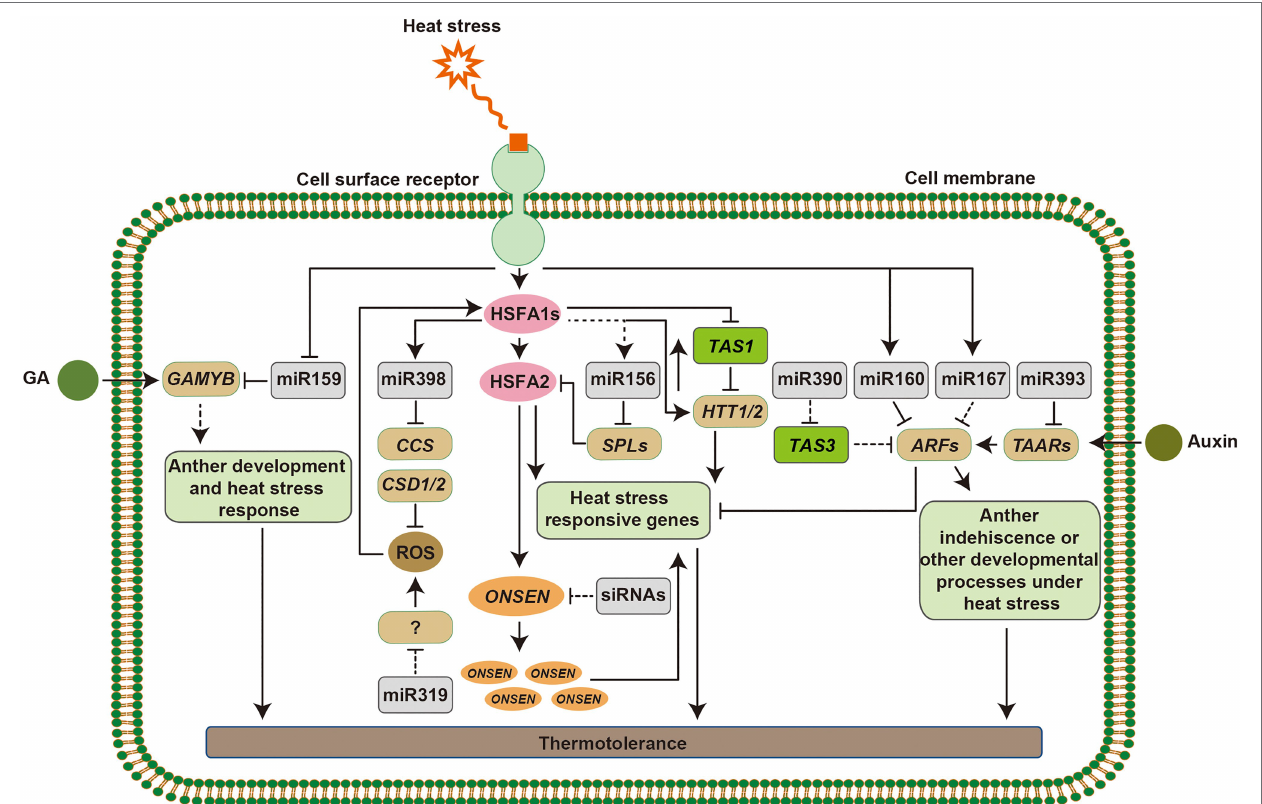
FIGURE 3 | Mechanism of small RNA (sRNA) regulation in plant responses to heat stress. Heat stress signaling can be perceived by putative sensors on the cell membrane, which induce the expression of heat stress responsive genes. HSFA1s function as master regulators to active the downstream heat stress responsive transcription factors and genes. Heat-induced miR398 downregulates CSDs and CCS . Accumulation of reactive oxygen species (ROS) in the cells acts as signals to alter the expression of heat shock transcription factors ( HSFs ), and miR319 functions in this pathway via unknown targets. HSFA1s directly activate the expression of HTT genes, targets of TAS1 , which upregulate HSF and heat shock protein ( HSP ) genes. The miR156- SPL module promotes sustained expression of heat stress- inducible genes in response to recurring heat stress and prolong the heat stress memory. In addition, the retrotransposition ONSEN is activated by HSFAs, although, siRNAs regulate its activity, which can be inherited to its progeny. miR159- GAMYB modules function in gibberellin (GA) signaling. miR160, miR167, miR390, and miR393 target AUXIN RESPONSIVE FACTOR ( ARF ) or TAARs that act in the auxin response pathway and show morphological adaptations under heat stress. Arrowed lines represent promotional effects and flat lines represent repressive effects. Dashed lines indicate hypotheses that need to be